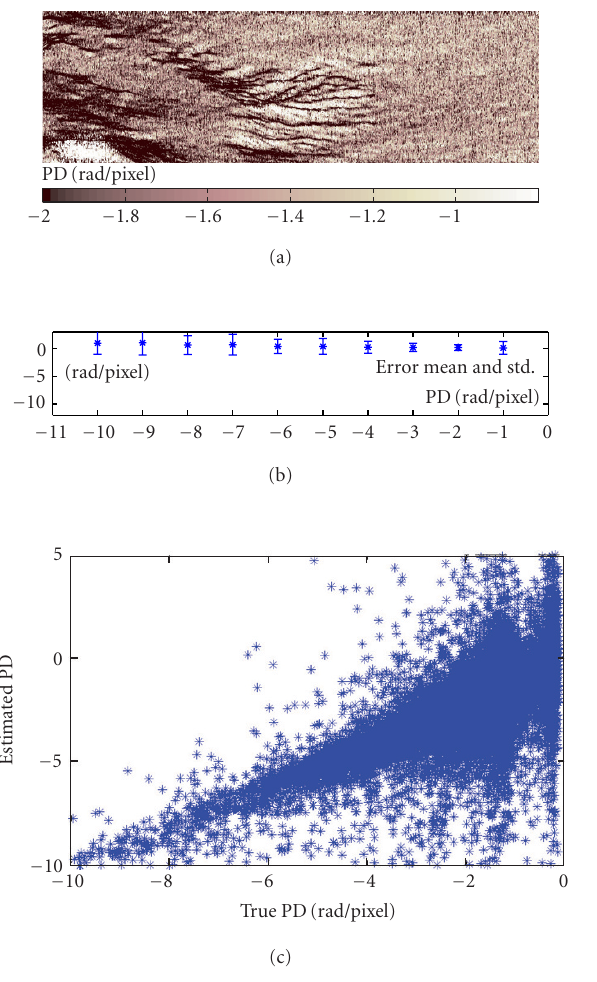
Figure 10: The same as Figure 8, but with using all the interfero- metric